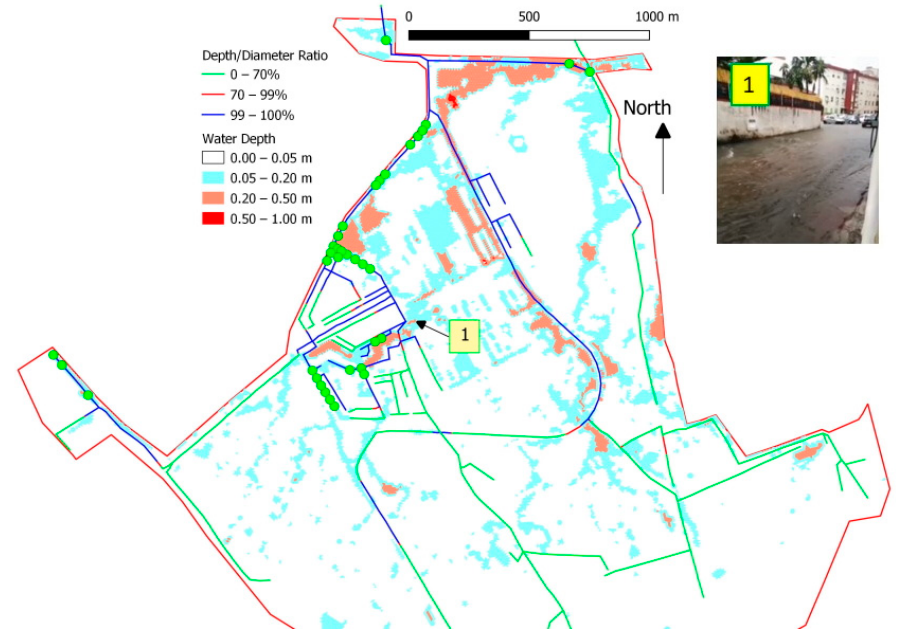
Figure 13. Results of validation event of 2 October 2021 (rain 43.0 mm). Part-full pipe flow (green lines) and surcharging pipe (blue lines). The green point indicates the local overflow at Piazza Castelforte, at the WTP and in other streets.